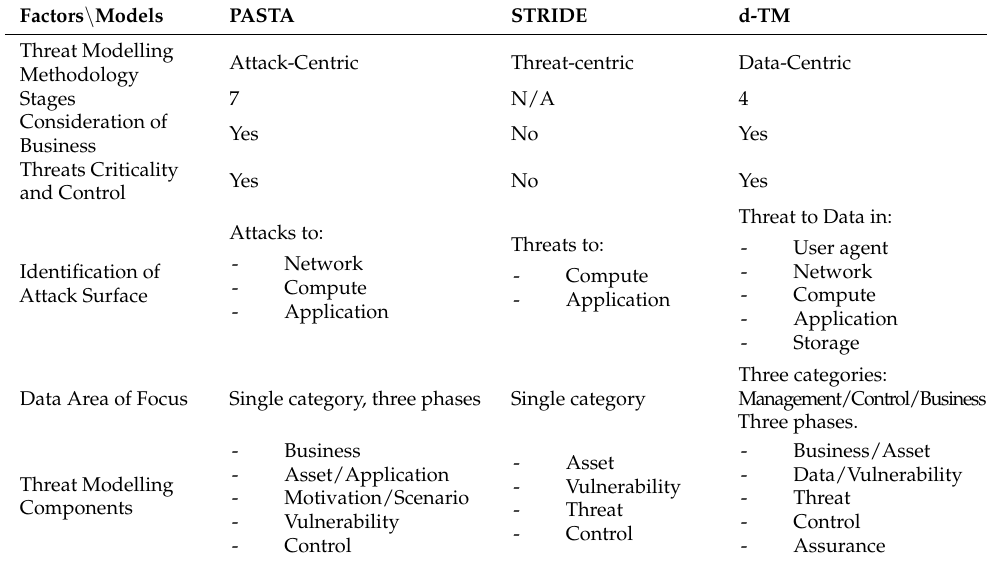
Table 9. d-TM Threat modelling